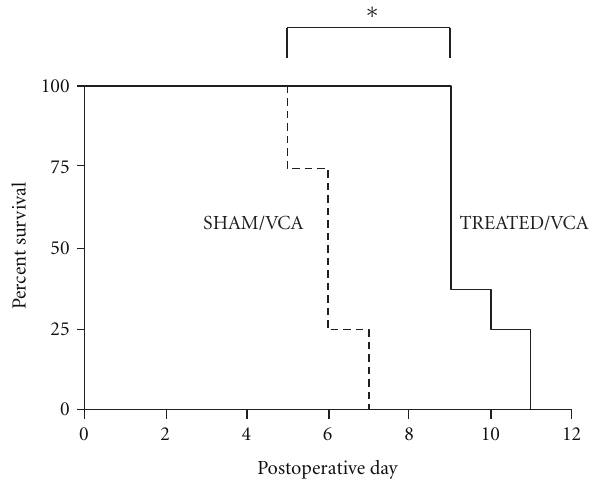
Figure 5: VCA rejection presented as survival curves using the product limit method of Kaplan and Meier. (dotted line— SHAM/VCA; solid line—TREATED/VCA; “ ∗ ” P < 0 . 0005).